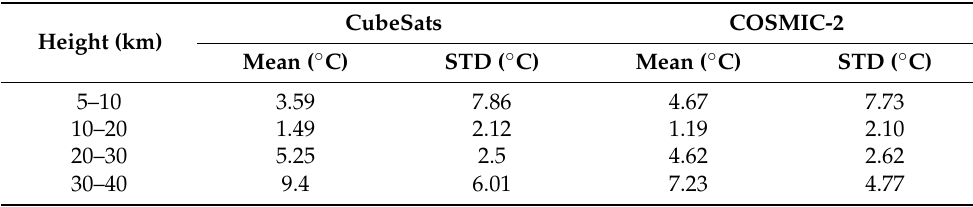
Figure 12. Number of occultations for the COSMIC-2 constellation and 17 CubeSats ( top ), Geographical coverage of the 17 tested CubeSats ( bottom left ), and COSMIC-2 constellation ( bottom right ) over the testing period (16 December 2020–15 January 2021). Table 8. Mean and standard deviation (STD) of the differences between the CubeSats and COSMIC-2 temperature values and the radiosonde observations for different